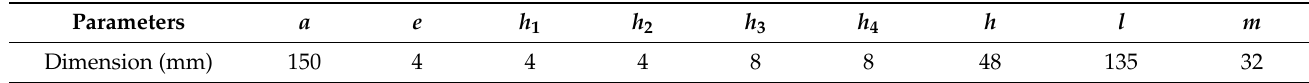
Table 4. Geometric parameters used in the experiment